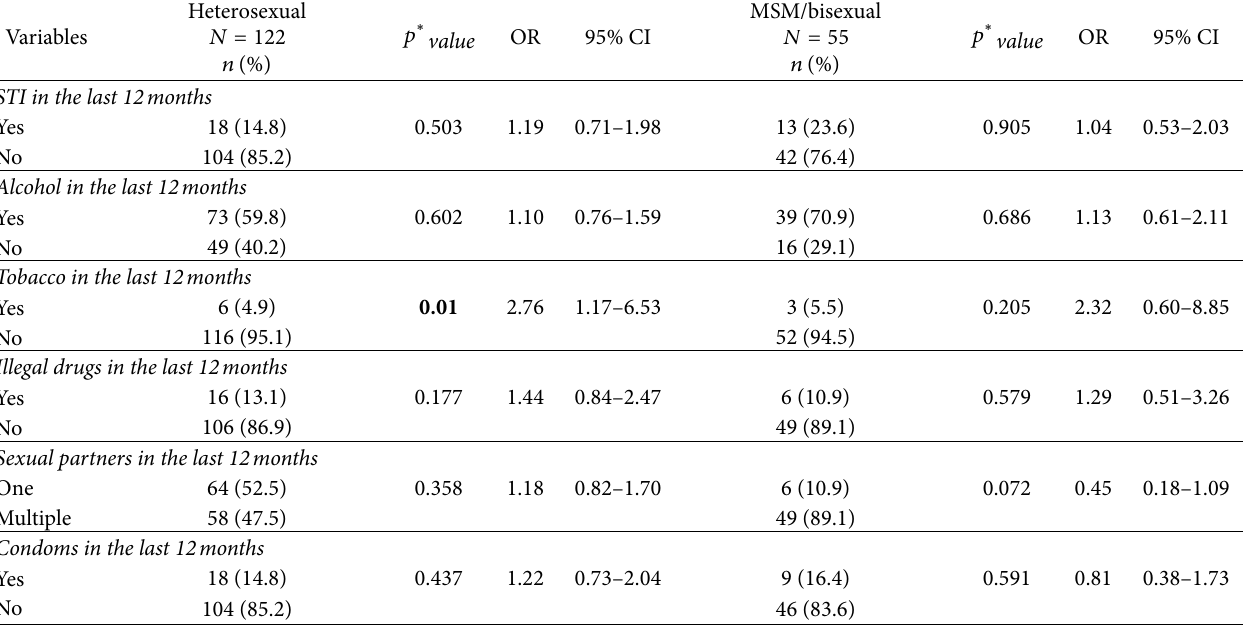
Table 3: List of behavioral variables according to the sexual orientation of individuals obtaining HIV-positive results ( 푛 = 177 ).